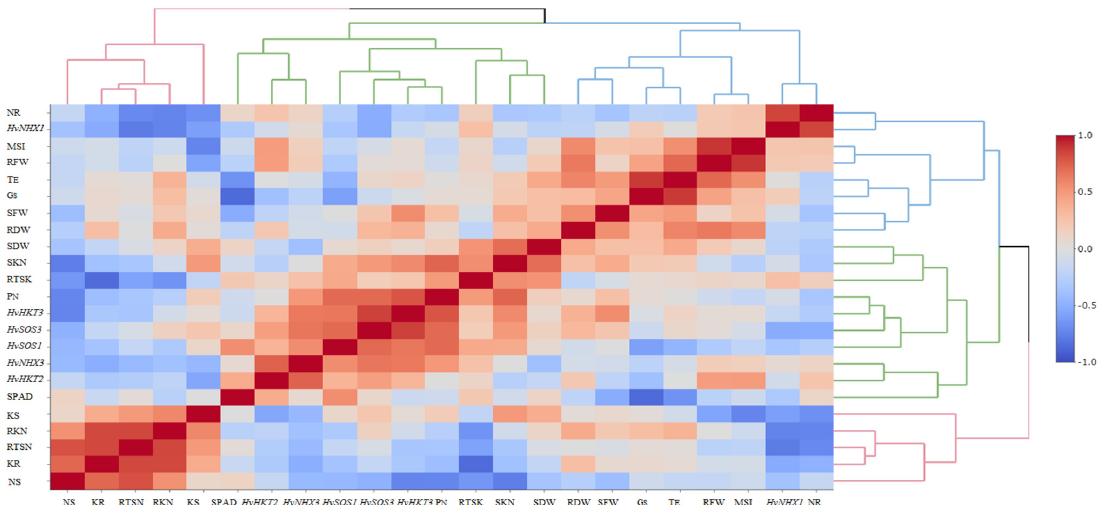
Figure 4. Correlation-based heatmap method reveals the association among measured traits and the relative gene expression patterns in the selected barley genotypes at the early growth stage. The different colors and intensities were adjusted based on associations among traits. RFW, root fresh weight; SFW, shoot fresh weight; SDW, shoot dry weight; SPAD, relative chlorophyll content; P N , photosynthetic rate; G S , stomatal conductance; T E , transpiration rate; MSI, membrane stability index; RN, root Na + content; RK, root K + content; SN, shoot Na + content; SK, shoot K + content; RKN, root K + :Na + ratio; SKN, shoot K + :Na + ratio; RTSN, root-to-shoot Na + translocation; RTKN, root-to-shoot K + translocation; HvNHX1 , expression of the HvNHX1 gene; HvNHX3 , expression of the HvNHX3 gene; HvSOS1 , expression of the HvSOS1 gene; HvSOS3 , expression of the HvSOS3 gene; HvHKT2 , expression of the HvHKT2 gene; HvHKT3 , expression of the HvHKT3 gene.